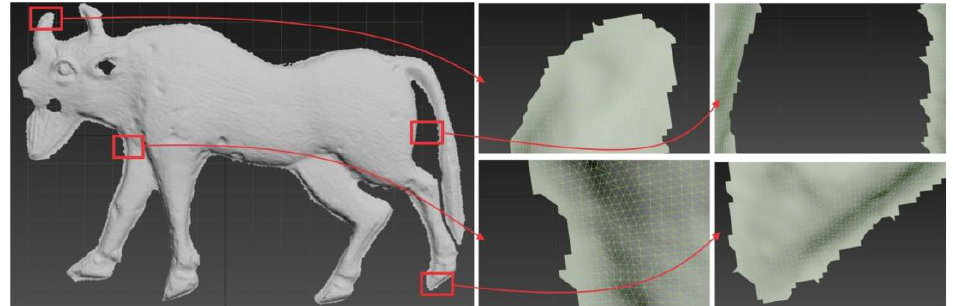
Figure 9. Close-up view of the triangulated area around the ornament.